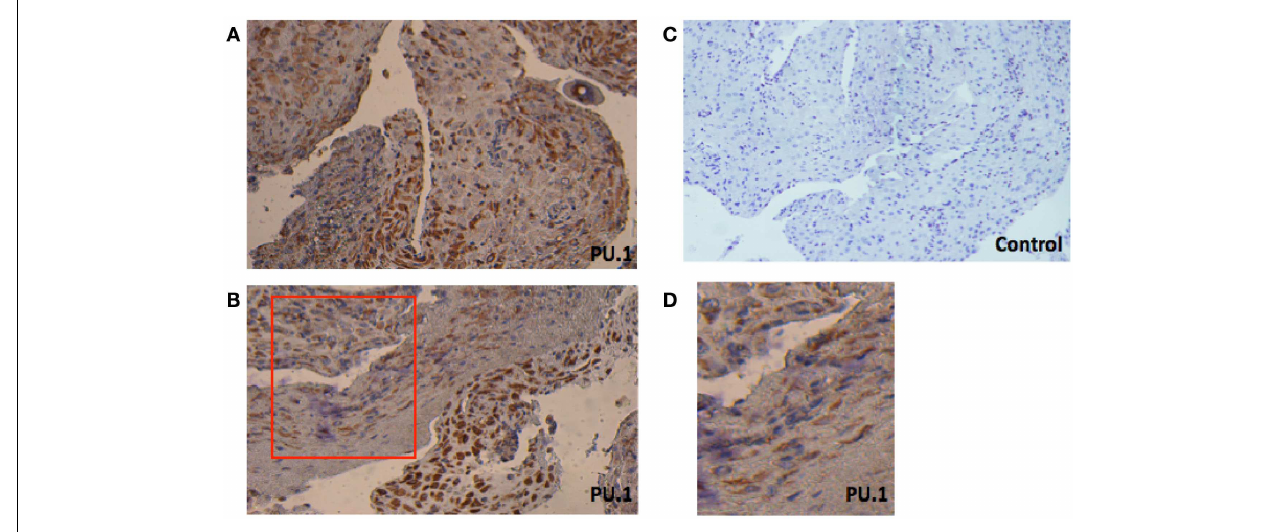
transcription factor is stained brown and hematoxylin in blue (A,B) . Control sections pre-incubated with rabbit IgG were uniformly negative (C) .The red box in (B) indicates enlarged image as seen in (D) .The experiment was performed using decidual tissues from five subjects. Original magnification 40 ×